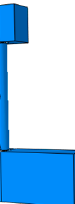
Figure 13. Finite element model of latticed concrete wall specimen with diagonal bracing.